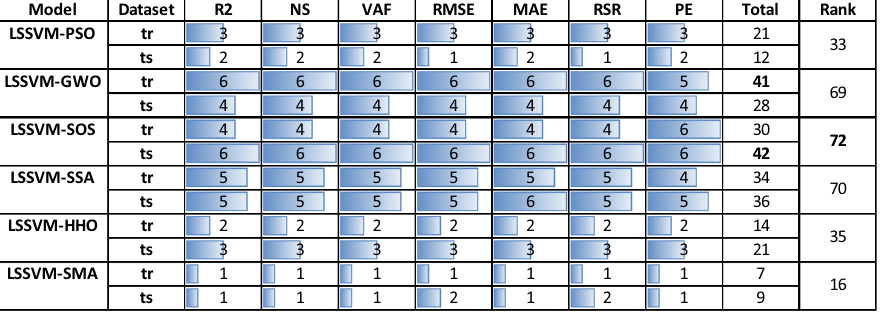
Table 6. Model’s rank evaluation. Significant values are in bold.